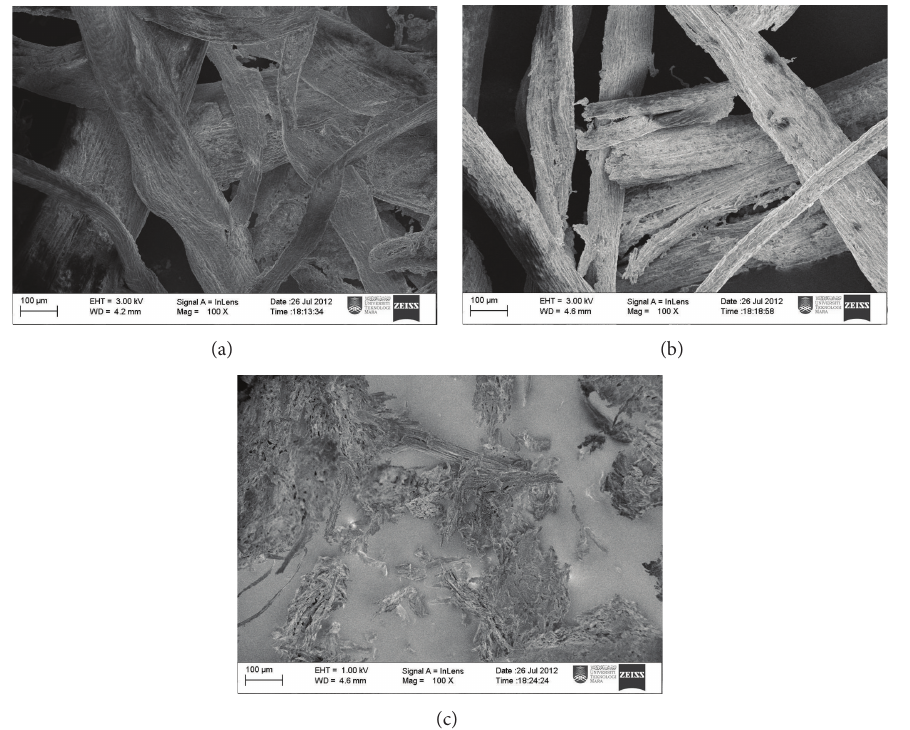
Figure 3: SEM images of (a) raw OPEFB fibers (b) delignified OPEFB (c) OPEFB cellulose.